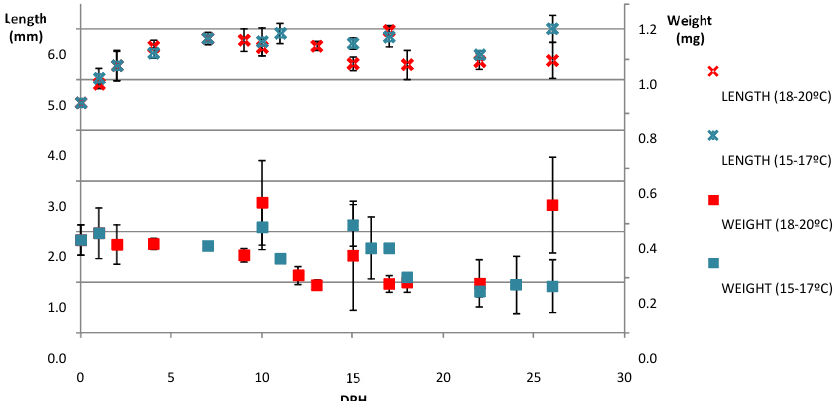
Figure 9. Mean growth (dry weight, squares) and length during temperature trials. The highest temperature is represented with the red color while the coldest one with the blue. The bars indicate standard deviation of the values.